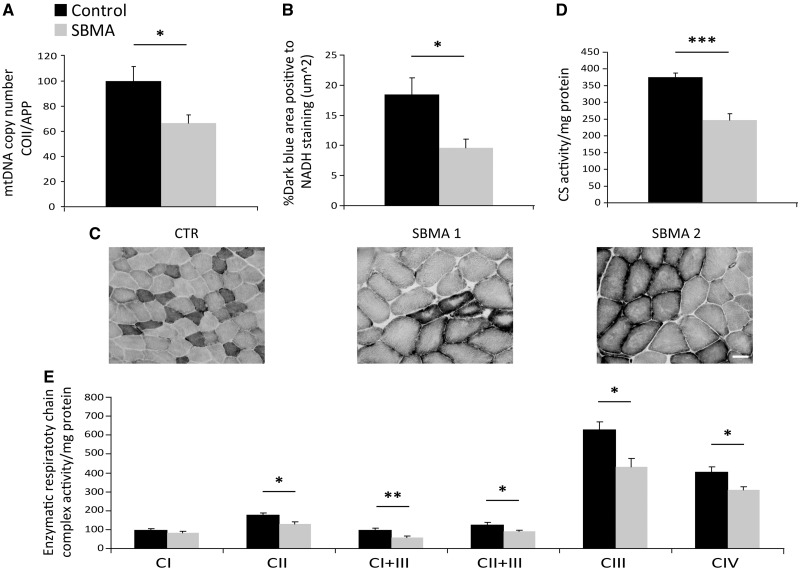
Reduction of mitochondria in the muscle of SBMA patients. (A) Real-time PCR analysis of mtDNA copy number measured as the ratio between cytochrome c oxidase II (COII) and nuclear amyloid precursor protein (APP) genes. Graph, mean ± SEM, n = 13 SBMA patients and 14 control subjects. (B) Mitochondrial mass expressed as the percentage of dark blue area in NADH-stained muscle cross-sections. Graph, mean ± SEM, n = 6 SBMA patients and 5 control subjects. (C) NADH analysis of quadriceps muscle of control and SBMA subjects. Scale bar, 80 μm. (D) Citrate synthase (CS) activity, expressed as nmol min−1 mg−1 of protein. Graph, mean ± SEM, n = 6 SBMA patients and 4 control subjects. (E) Activity of the respiratory chain complexes I–IV, expressed as nmol min−1 mg−1 of protein. Graph, mean ± SEM, n = 6 SBMA patients and 4 control subjects. Significance by Student’s t test: *P < 0.05, **P < 0.01, ***P < 0.001.